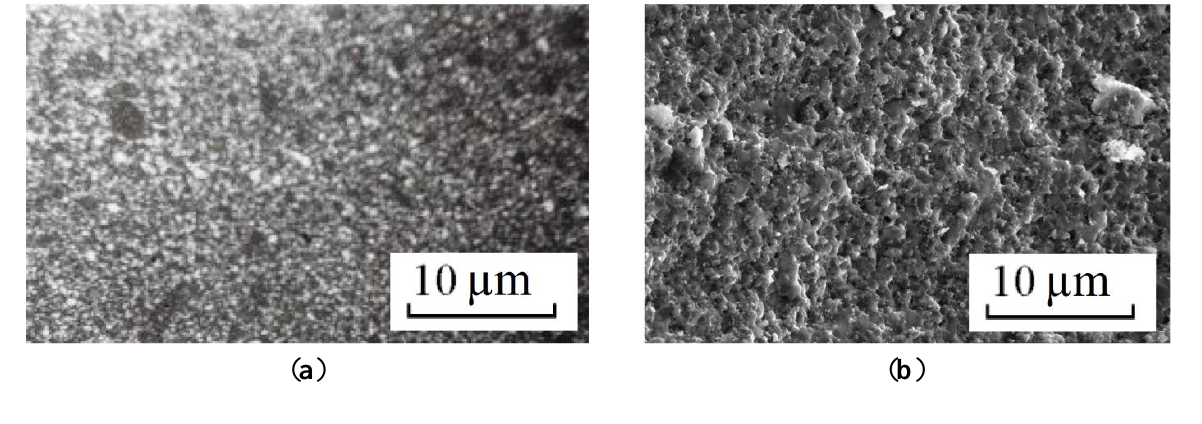
Figure 42. Microstructure ( a ) and fracture surface ( b ) of the sintered Al (50/50 wt